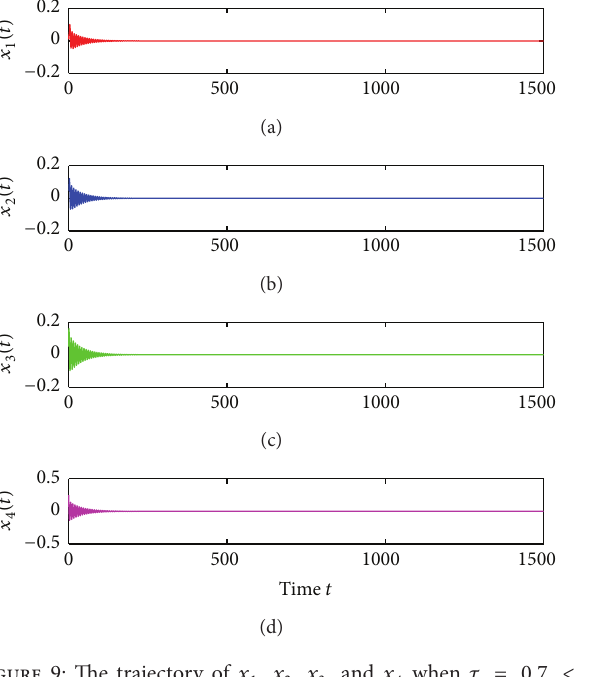
Figure 9: The trajectory of 𝑥 1 , 𝑥 2 , 𝑥 3 , and 𝑥 4 when 𝜏 = 0.7 < 0.7915 = 𝜏